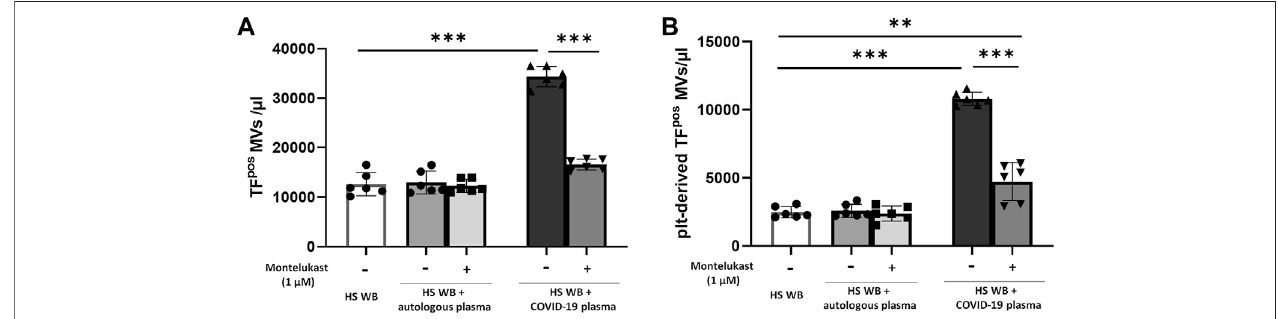
FIGURE 3 | In vitro effect of montelukast on microvesicle (MV) release induced by COVID-19 plasma. Whole blood (WB) from healthy subjects (HS; n = 3), pre- incubated with montelukast (1 µM) as indicated, was plasma-depleted and reconstituted with the COVID-19 plasma pool (dark gray bars) or autologous plasma (light gray bars). Thenumber of TF pos (A) and platelet-derived TF pos -MVs (B) was measured by fl owcytometry. Data are reported as mean ± SD. ** p < 0.01; *** p < 0.001 (TF, tissue factor; plt, platelets).